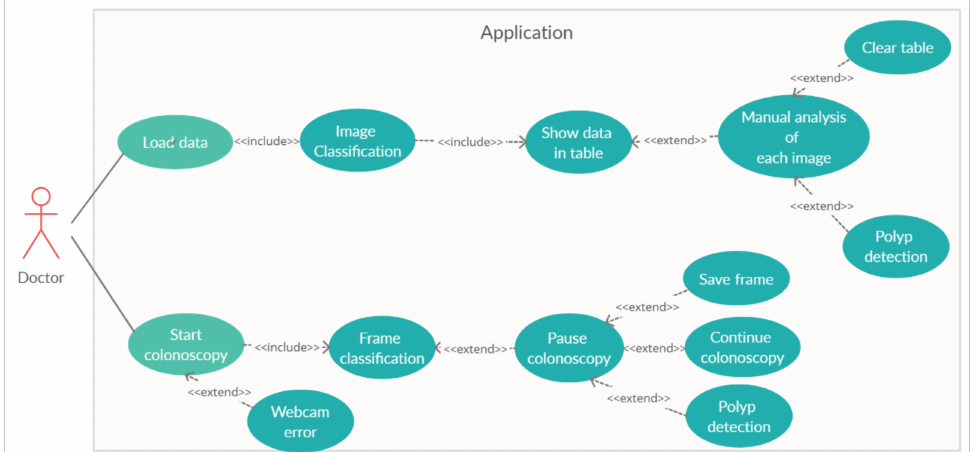
Figure 7. The use-case